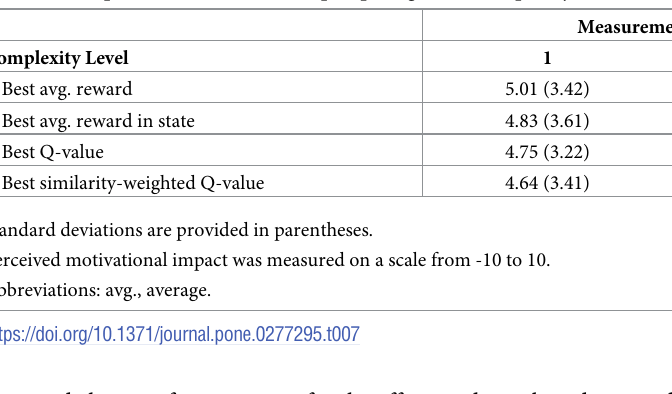
Table 7. Mean perceived motivational impact per algorithm complexity level and measurement moment.